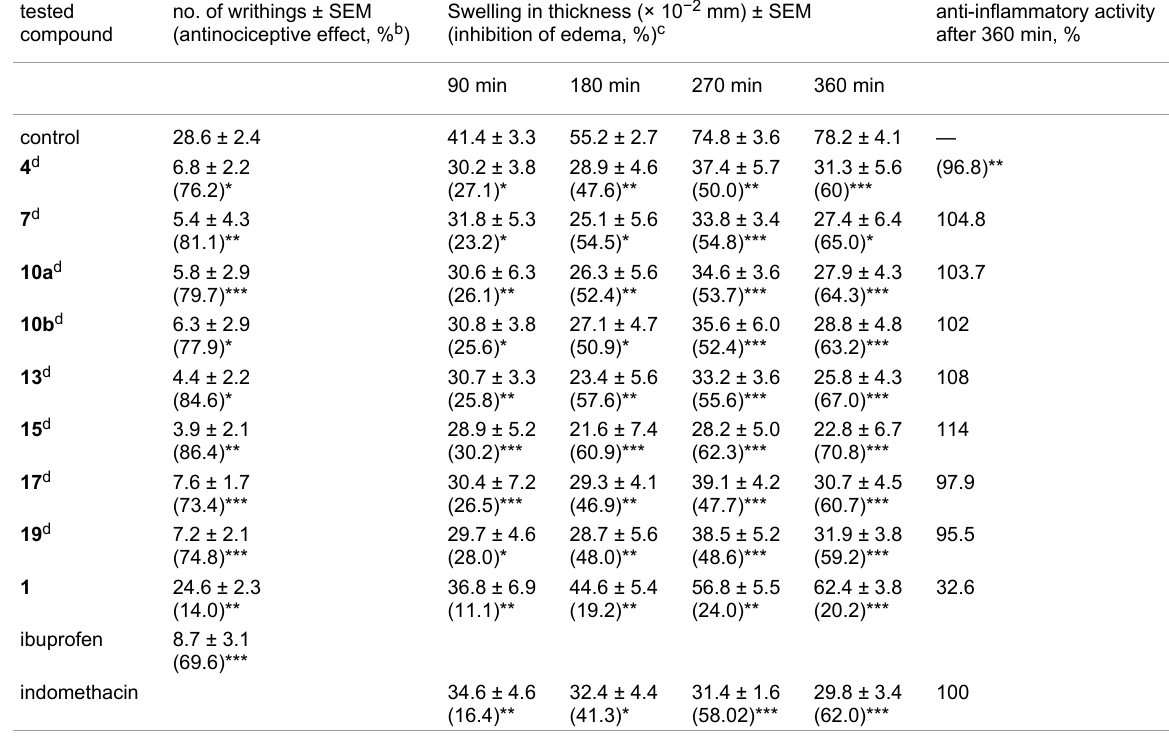
Table 1: Antinociceptive/anti-inflammatory effects of the tested compounds on the p- BQ-induced abdominal constriction test and carrageenan (CG)- induced hind paw edema model in mice. a tested compound